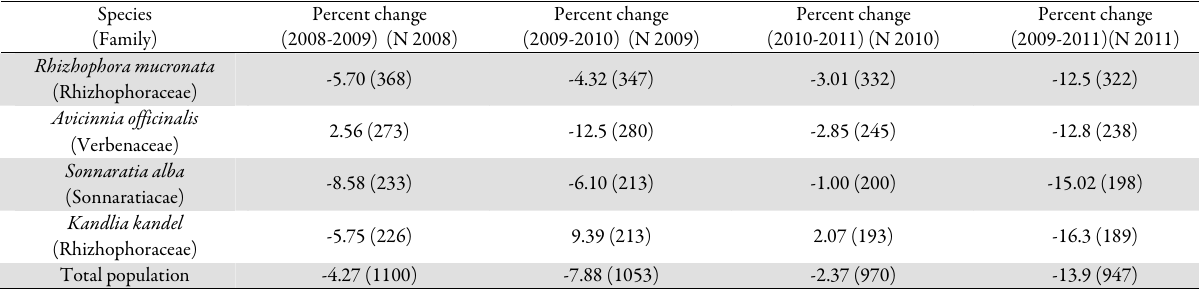
Tab. 2. Population changes observed in Kagekanu permanent vegetation plot